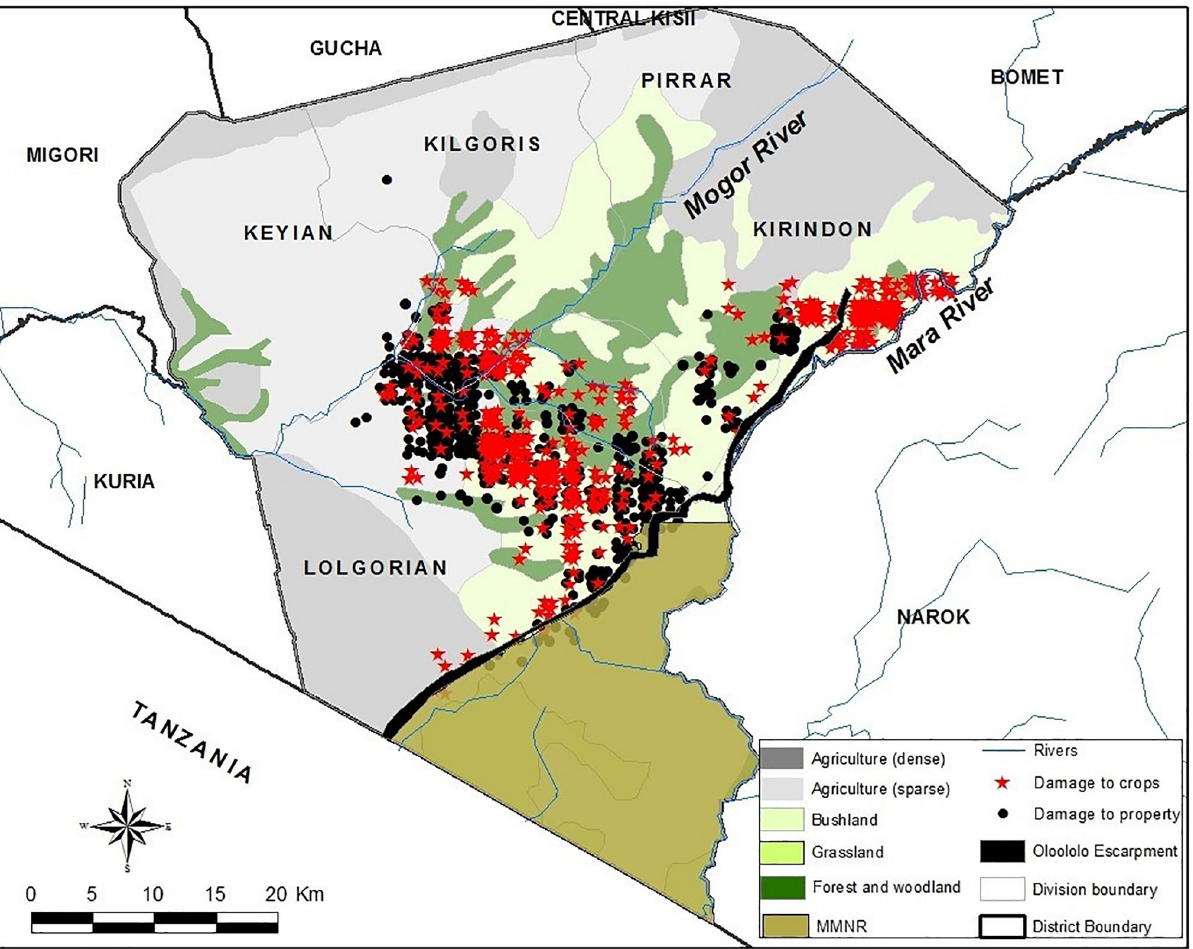
Fig 1. Trans Mara District showing land use and land cover, administrative divisions and spatial distribution of HEC (source Nyumba et al., 2020 [53]).